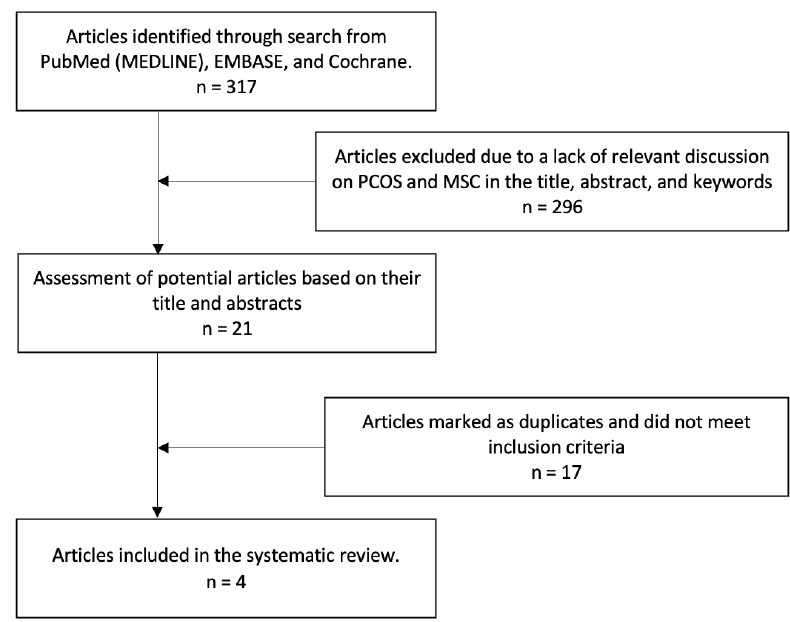
Figure 1 . Flowchart of study selection process. Figure 1. Flowchart of study selection